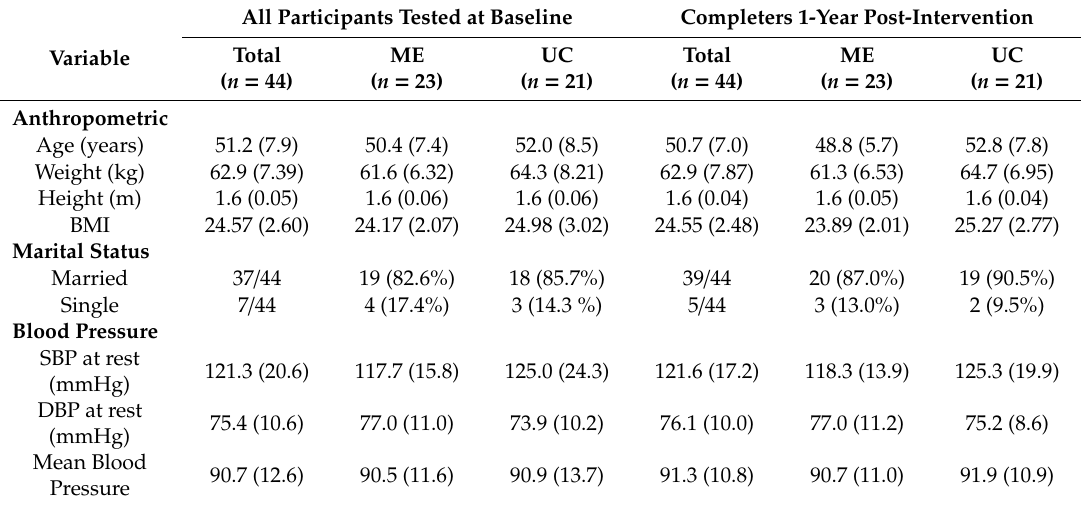
Table 1. Participants’ characteristics at baseline and di ff erences between